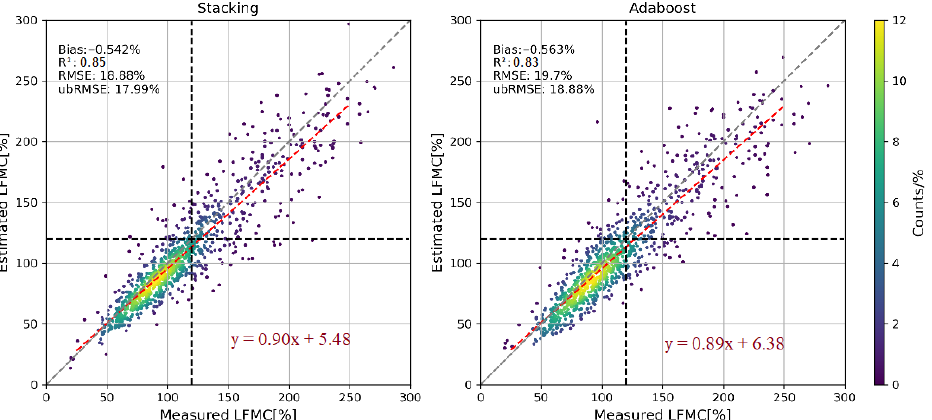
Figure 6. LFMC retrieval results based on MODIS, Landsat-8 and Sentinel-1. The gray dotted line and the black dotted line represent the 1:1 line and the 120% fire risk based on level of moisture, respectively, and the red dotted line is the fitting line of the model retrieval results.